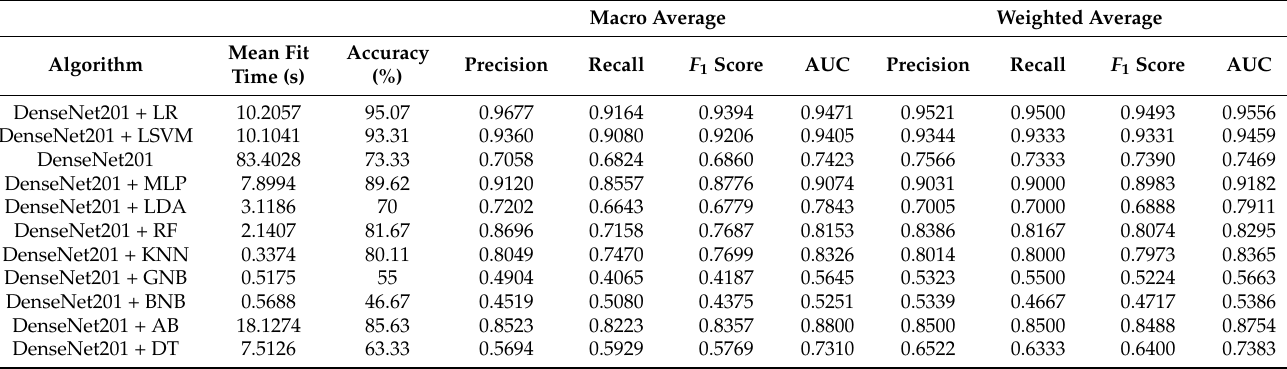
Table 6. Test results of algorithms used in the application. Macro Average Weighted